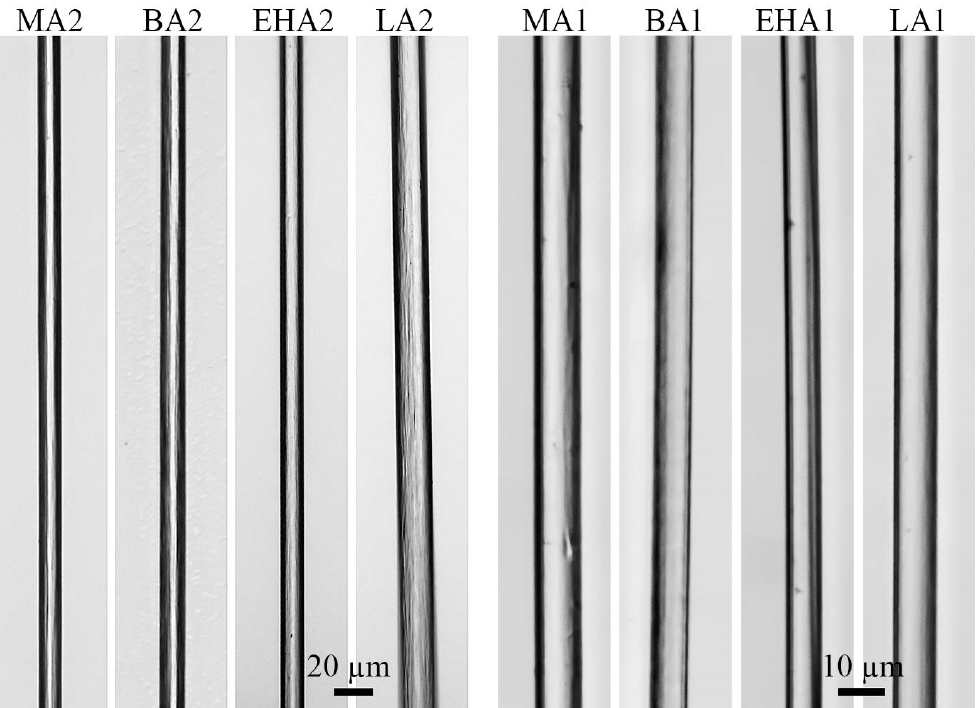
Figure 7. Optical micrographs of terpolymer-based fibers with various alkyl acrylate comonomers.